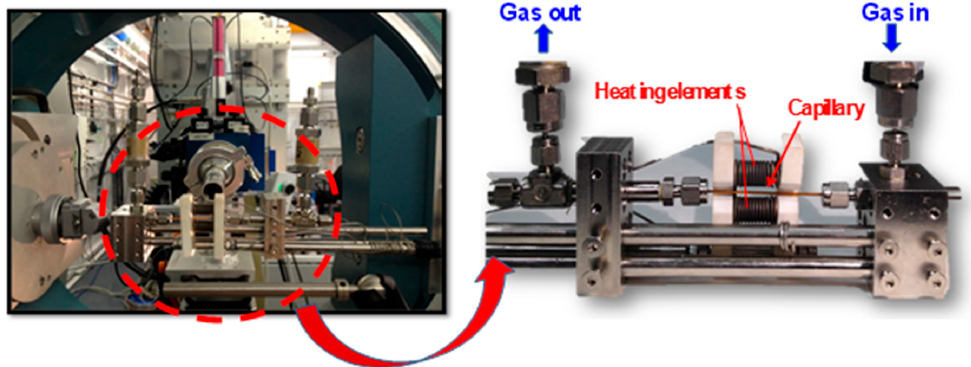
Figure 8. ICP ‐ ITQ ‐ ALBA capillary flow cell installed at the BL04 ‐ MSPD beamline, in the powder Figure 8. ICP-ITQ-ALBA capillary flow cell installed at the BL04-MSPD beamline, in the powder diffraction station. diffraction